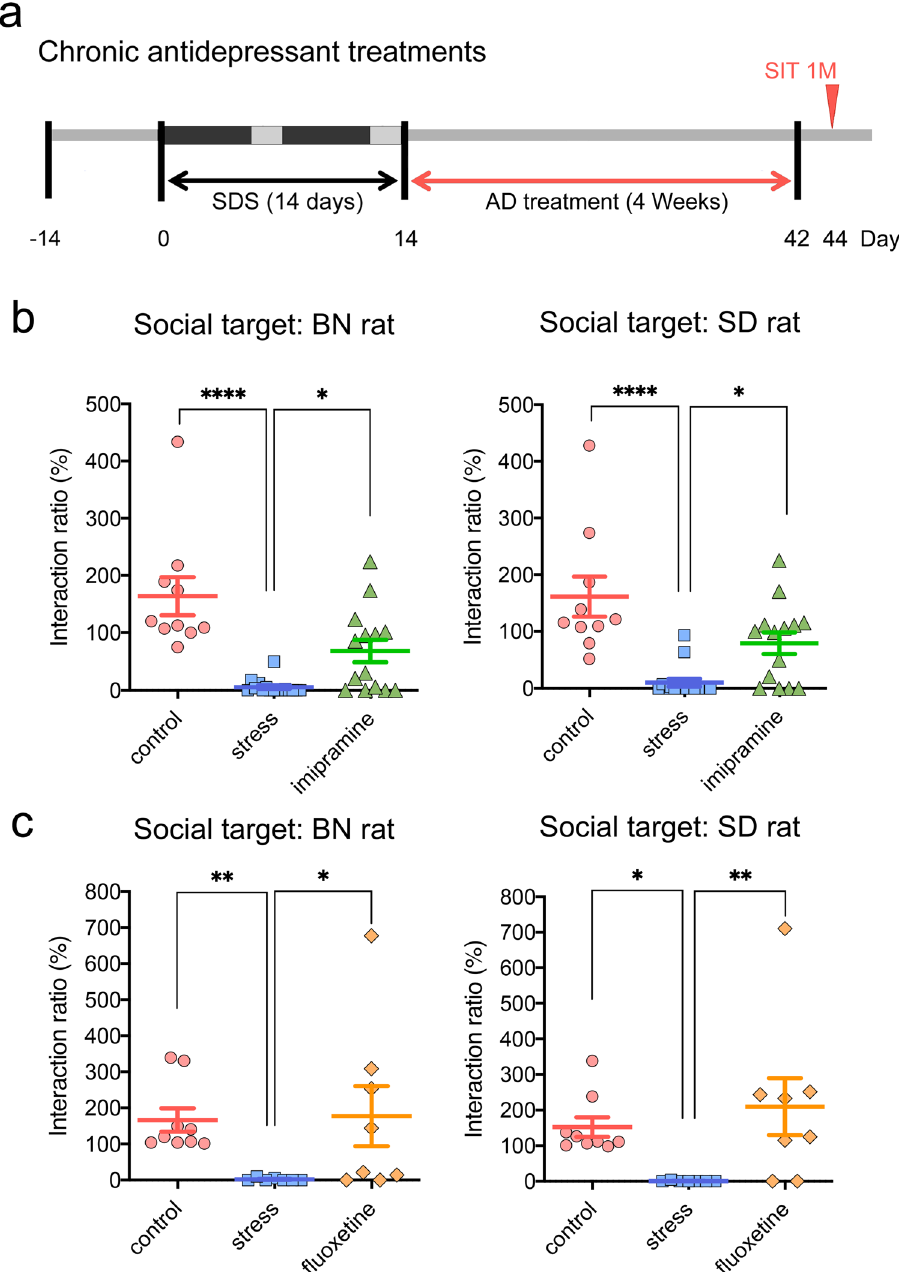
Figure 2. Effects of chronic antidepressant (AD) treatment on social avoidance. ( a ) Experimental schedule for chronic (4 weeks) AD treatment. ( b , c ) Social interaction test (SIT) at 1 month after the last social defeat stress (SDS) (Day 44, n = 7–16/group). Note that the AD groups included a certain proportion of nonresponders. * p < 0.05, ** p < 0.01, **** p < 0.0001, Kruskal–Wallis test followed by Dunn’s multiple comparisons